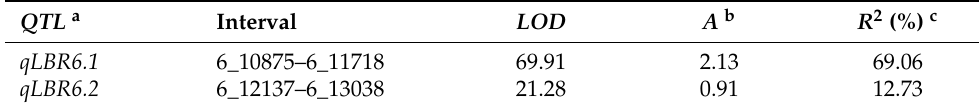
Table 4. QTL detected for LBR in the D71/ZH161 RIL